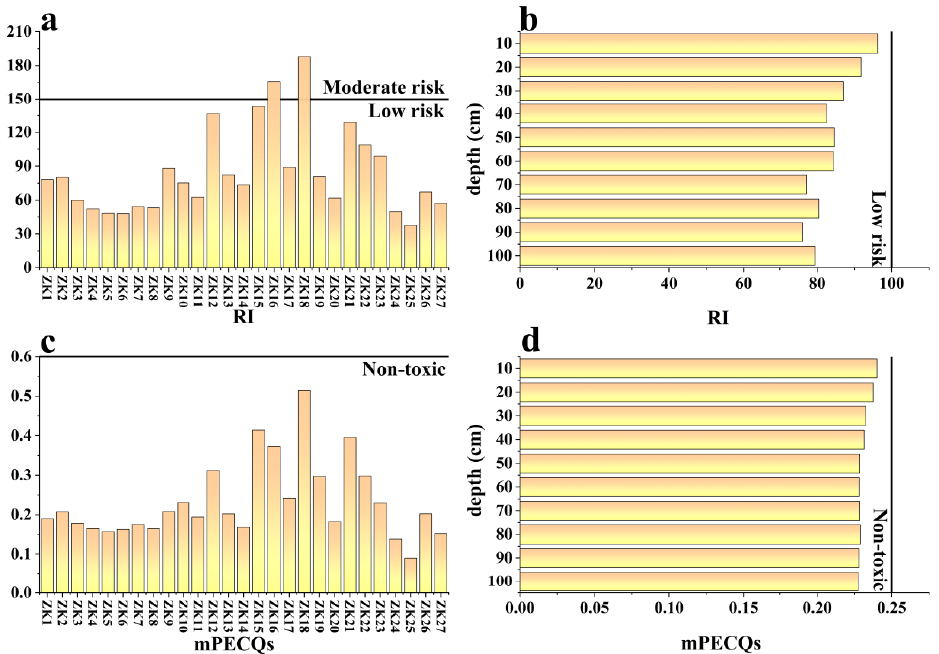
Figure 9. Potential ecological risk index (RI). ( a ) The result of overall comprehensive ecological risk assessment within 0–100 cm of wetland sediment. ( b ) The result of comprehensive ecological risk assessment at each layer within 0–100 cm in the wetland sediment. Multiple probable effect concentrations quality (mPECQs). ( c ) The result of overall comprehensive ecological risk assessment within 0–100 cm of wetland sediment. ( d ) The result of comprehensive ecological risk assessment at each layer within 0–100 cm in the wetland